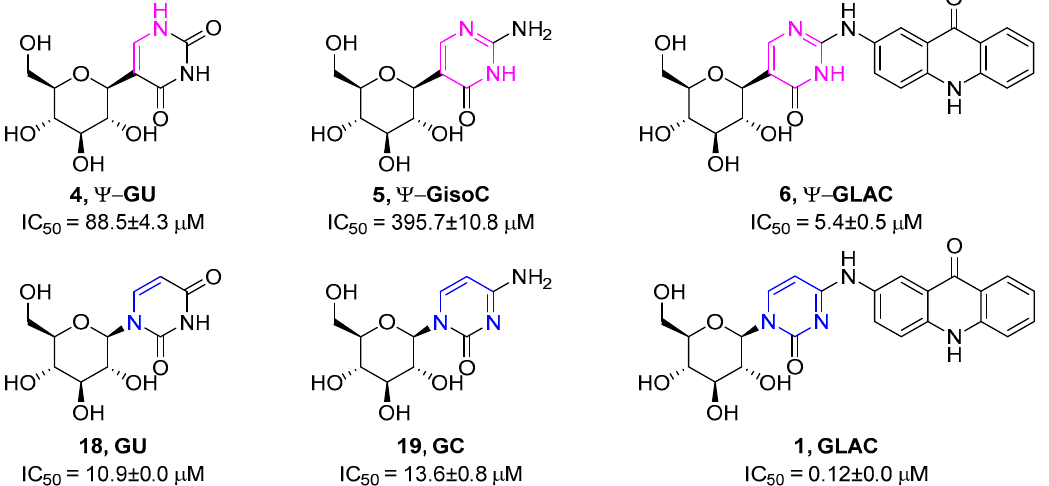
Figure 2. Measured values of the half maximal inhibitory concentration (IC 50 ) for 4 – 6 and comparison with known derivatives. The structural changes between the new C - and the reported N -glycosyl RMGP inhibitors are indicated in magenta and blue.